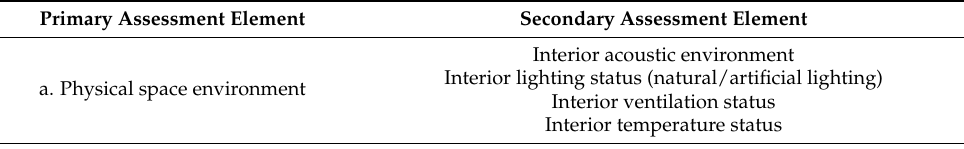
Table 2. Checklist for assessing the university library space user